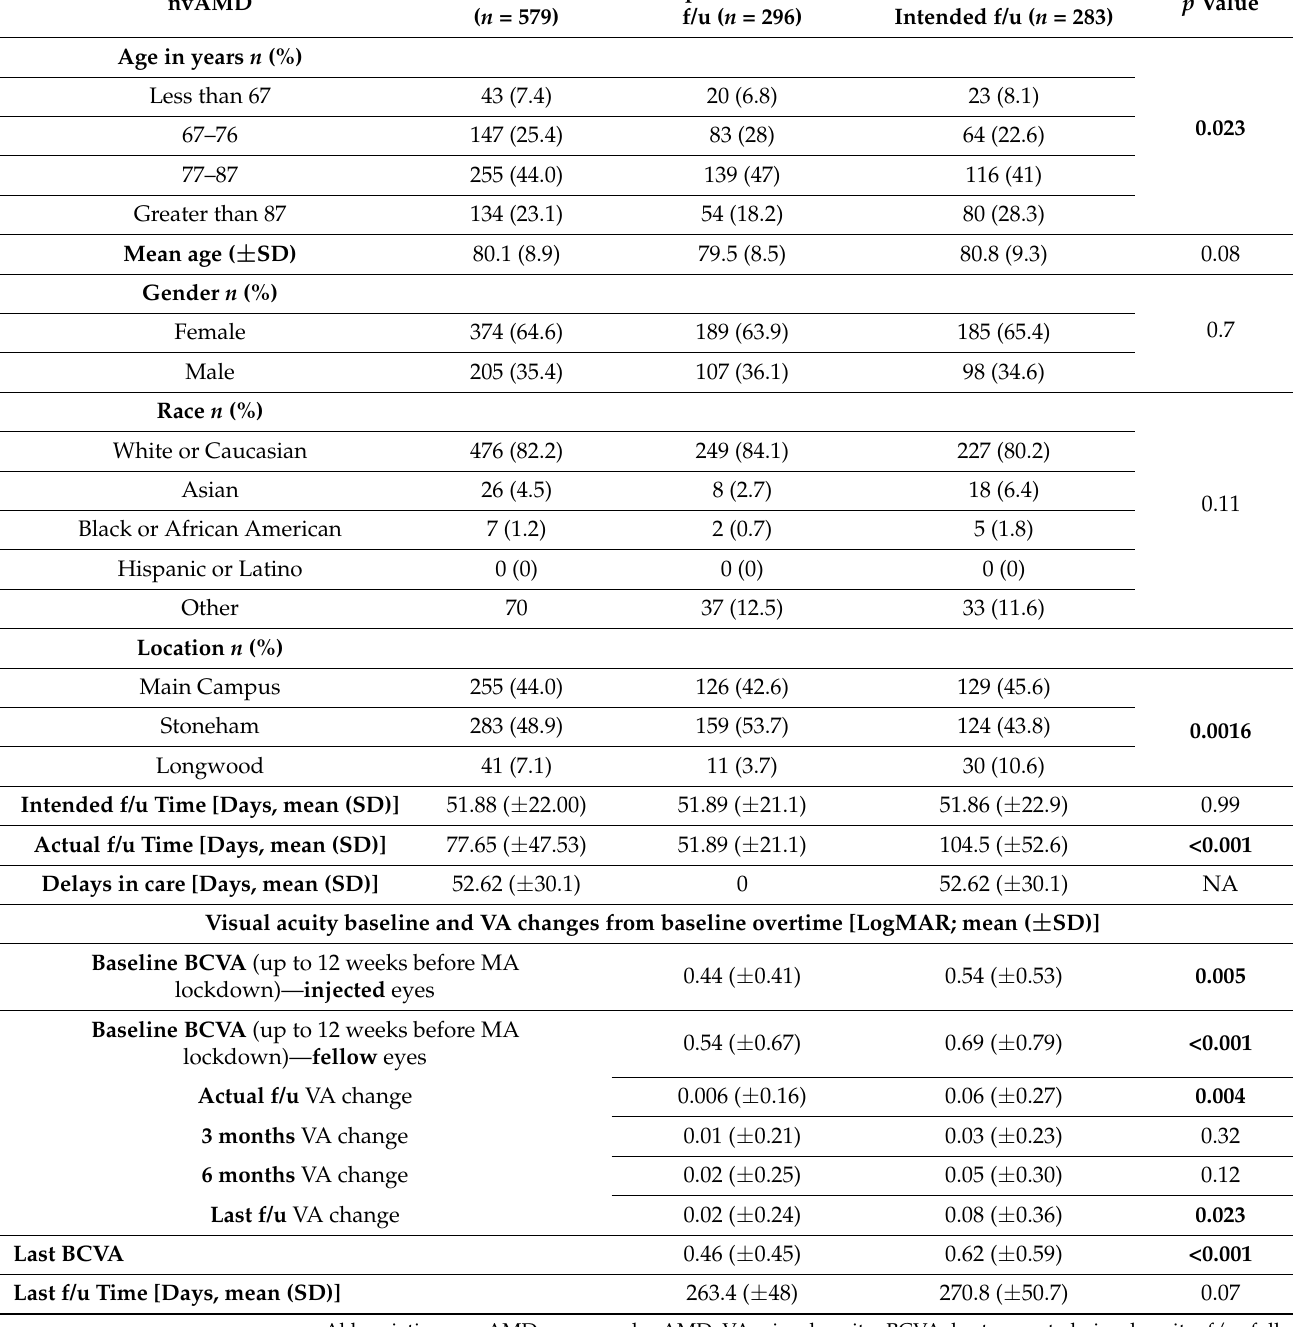
Table 2. Demographic and clinical characteristics of nvAMD